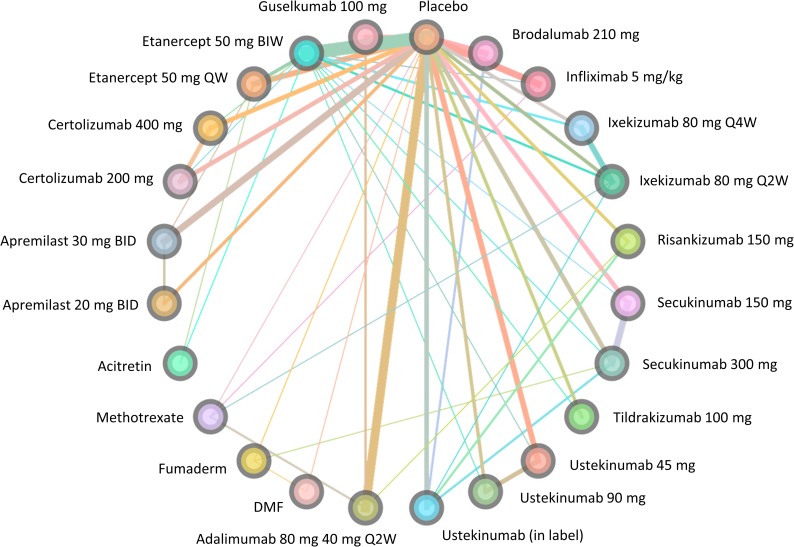
Network diagram for the base-case analysis.